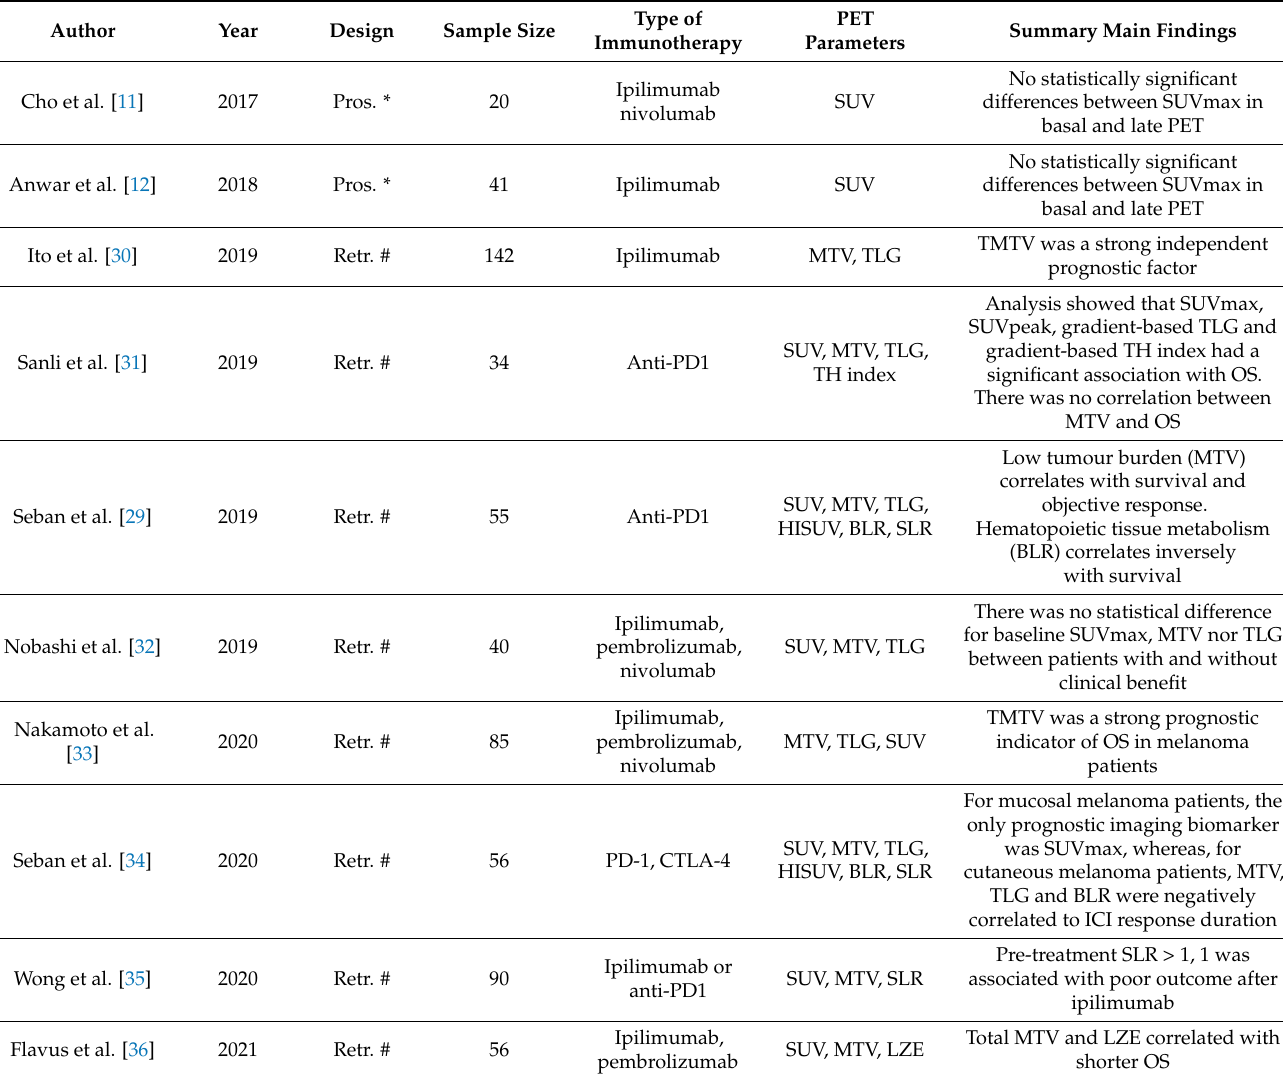
Table 1. Characteristics of the articles included and main